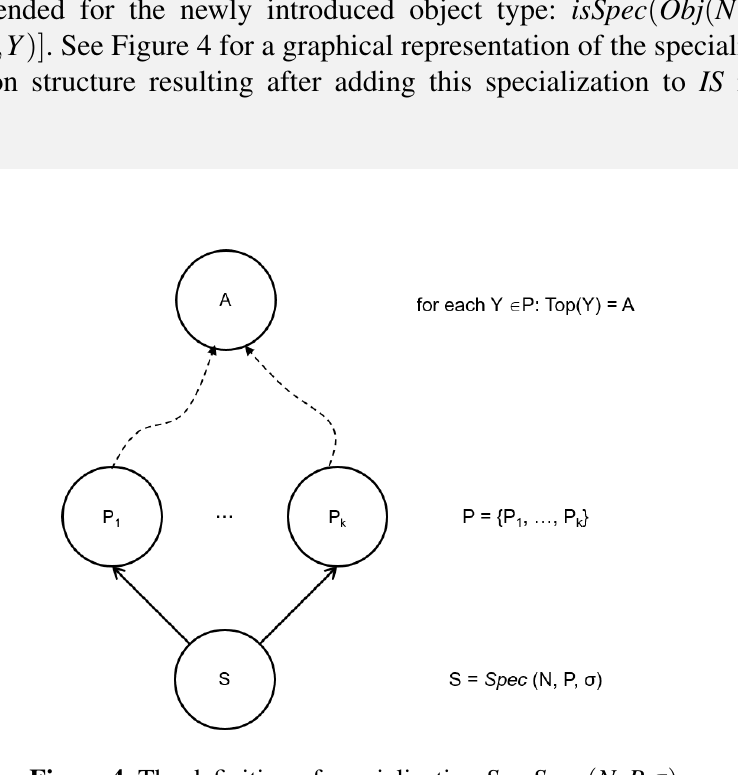
Figure 4. The definition of specialization S = Spec ( N , P , σ